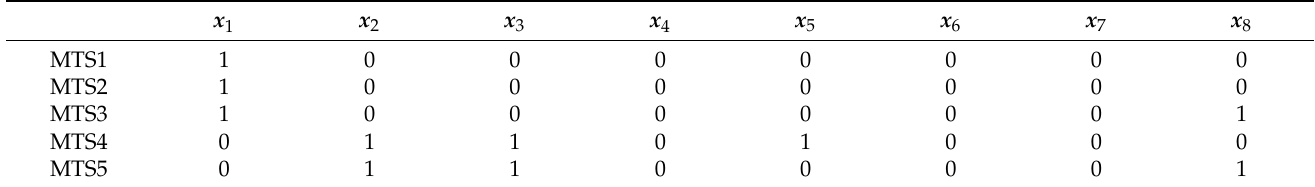
Table 11. Feature variable selection results of optimized BT-MTS of the glass data set.